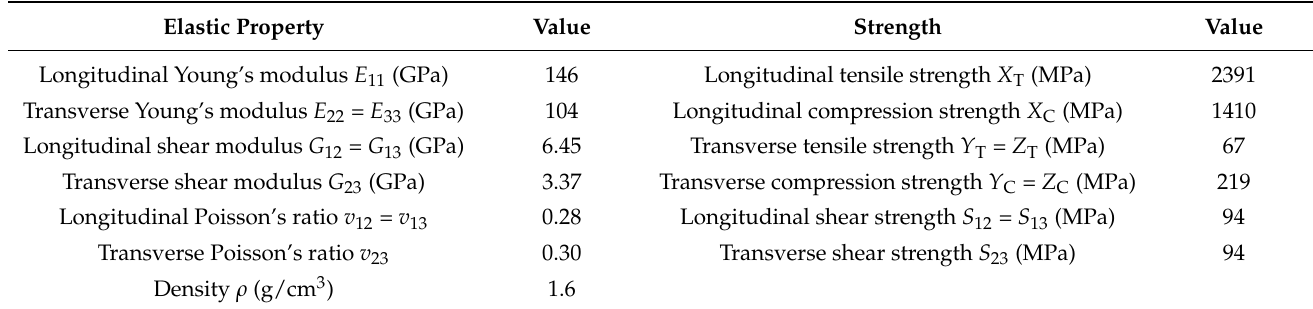
Figure 1. Photographs and schematic diagram of the tensile test specimen (all dimensions in mm). Table 1. Material properties of T700/QY9611.